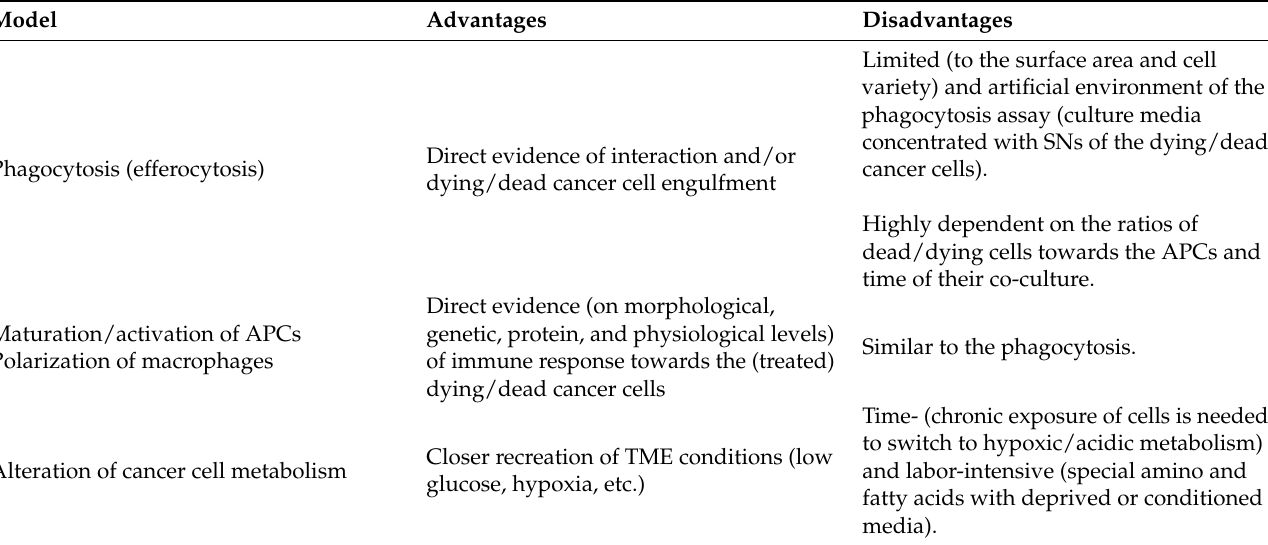
Figure 2. Two-dimensional models to study ICD. ( A ) Co-cultures of cancer cells ongoing ICD and antigen presenting cells (APCs) can be used to study efferocytosis and the APC status (e.g., maturation/activation). ( B ) Chemoattraction and migration can be assessed through Transwell migration assays. Table 1. Advantages and disadvantages of 2D TME models and